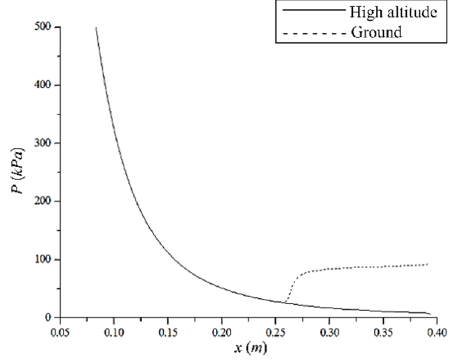
Figure 12. Pressure distribution, Pc = 4.34 MPa.